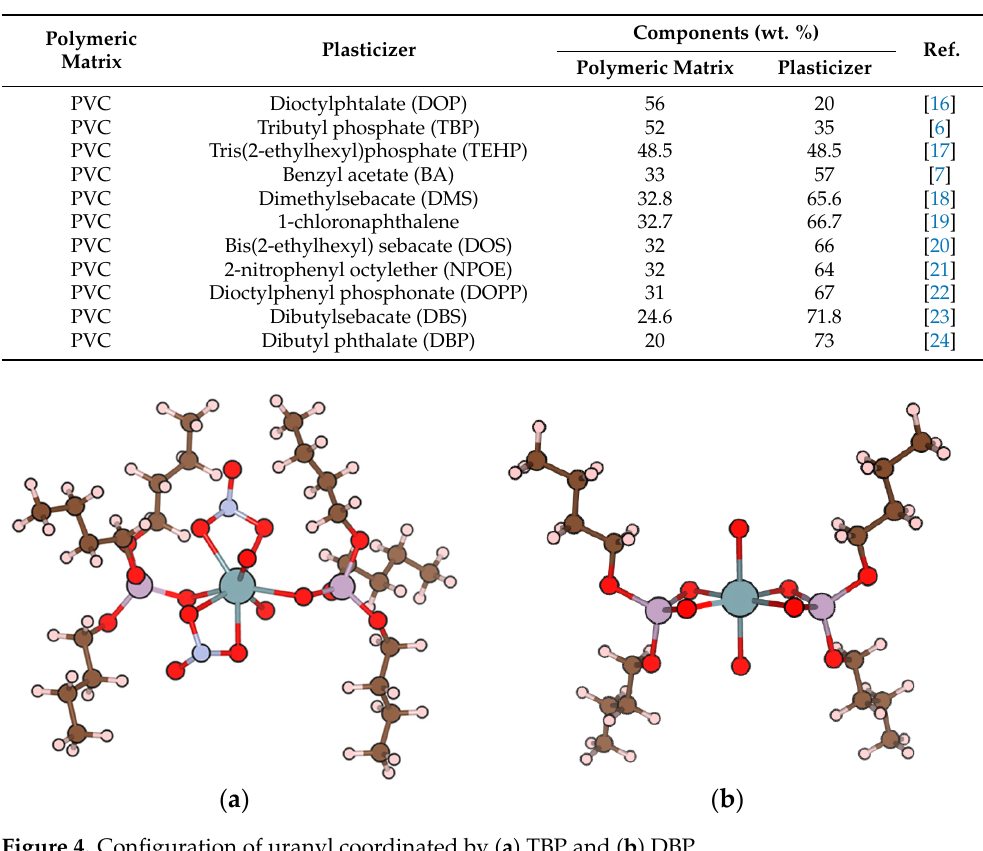
Table 1. An overview of polymer matrixes, plasticizers and their weight percentage in uranyl ion selective membranes.